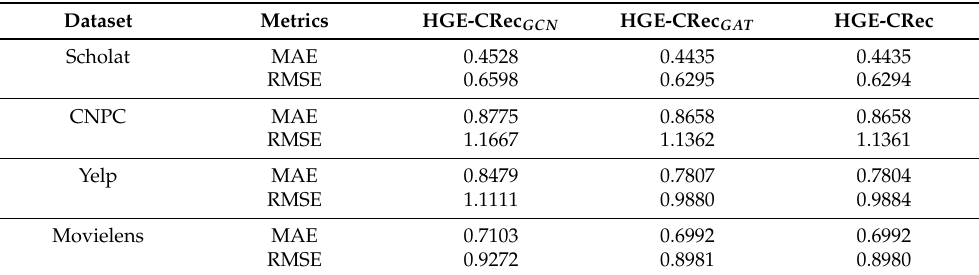
Table 8. Results of ablation study on component adjustment.